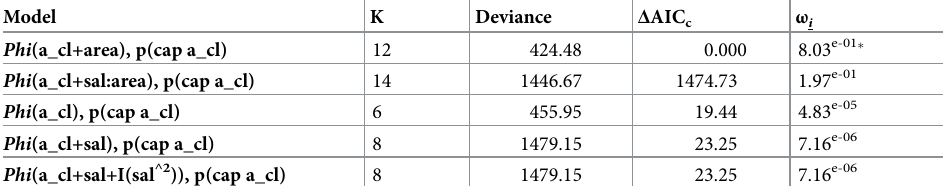
Table 3. Model selection for survival probabilities ( F ) of American crocodiles ( Crocodylus acutus ) in South